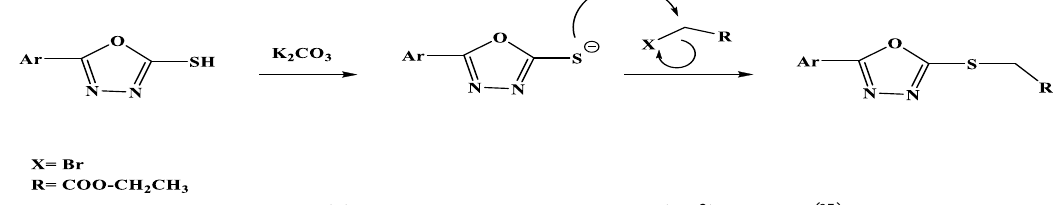
Figure 5. synthesis of compound (4) by nucleophilic substitution (SN 2 ) reaction (37) . FTIR spectrum was characterized by 1744cm